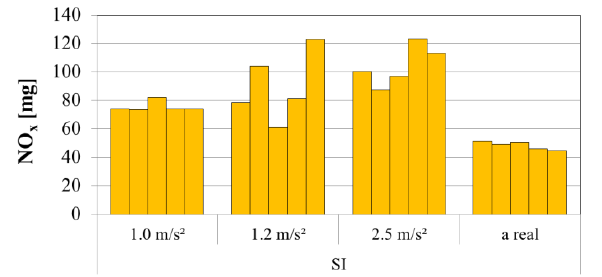
Fig. 19. CO 2 emission for different acceleration characteristics of a vehicle Fig. 17. NO x emission for different acceleration characteristics of a vehicle propelled with SI Euro 3 engine obtained during simulation using PTV propelled with SI Euro 3 engine obtained during simulation using PTV Vissim software Vissim software